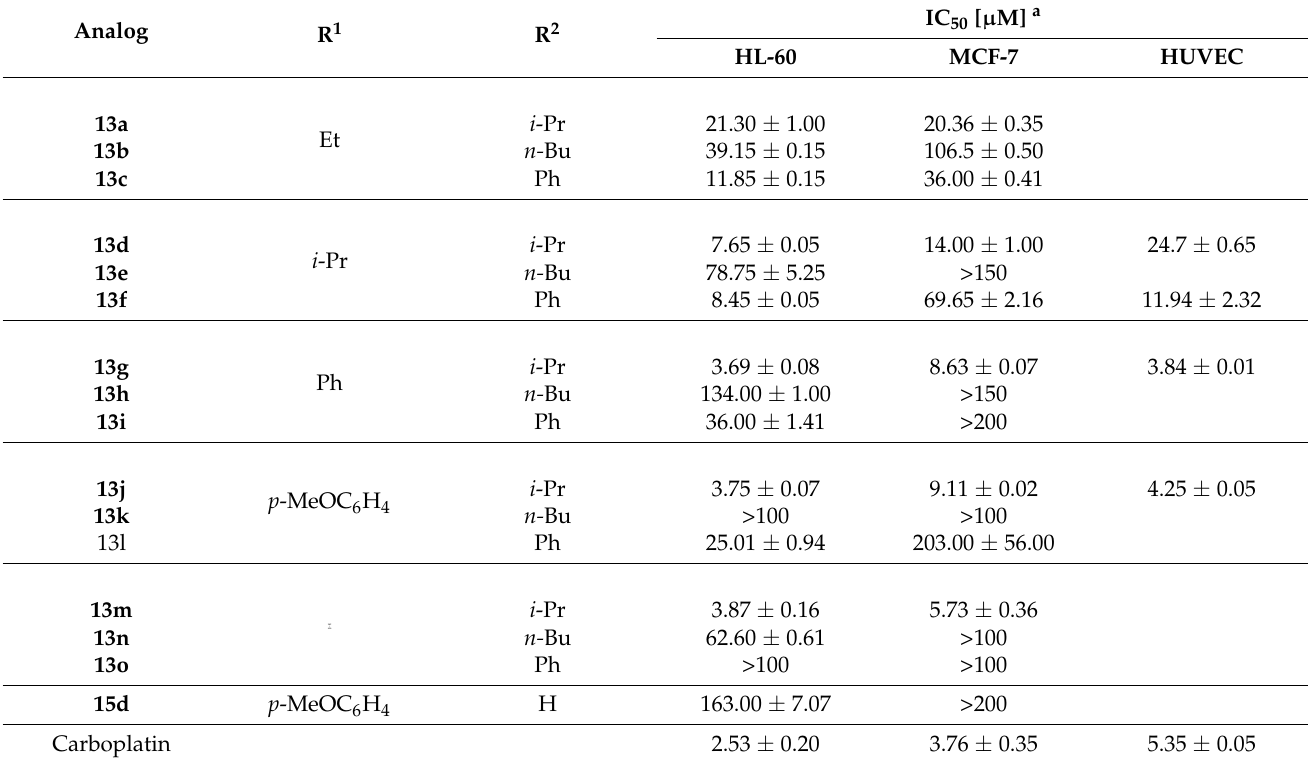
Table 6. In vitro cytotoxic activity of methylidenetetrahydropyran-4-ones 13a–o and 15d tested on two cancer cell lines and one normal cell